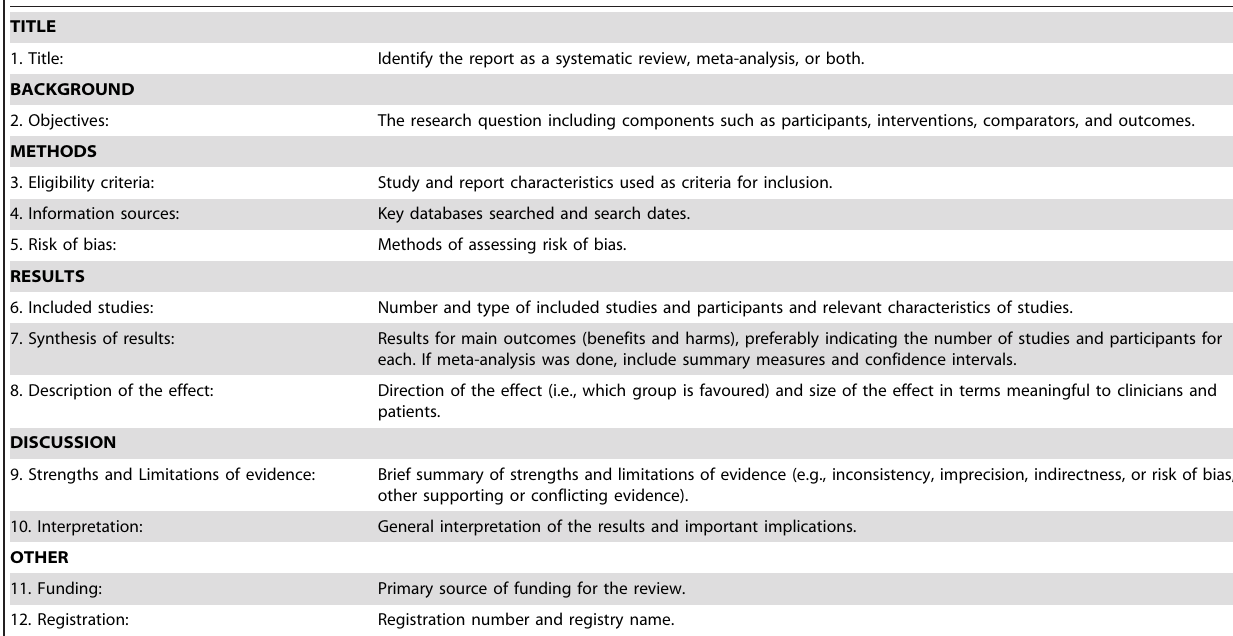
Table 1. The PRISMA for Abstracts